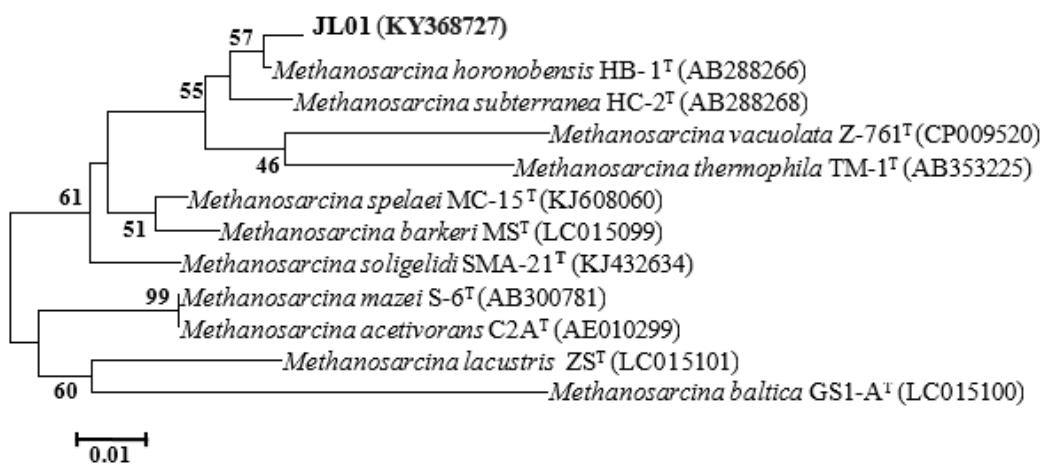
Figure 2. Phylogenetic tree based on mcr A gene sequences showing the relationship between the strain JL01 T and other members of the genus Methanosarcina . The numbers at the branch nodes indicate bootstrap percentages based on the neighbor-joining method (1000 replicates). Accession numbers are shown in